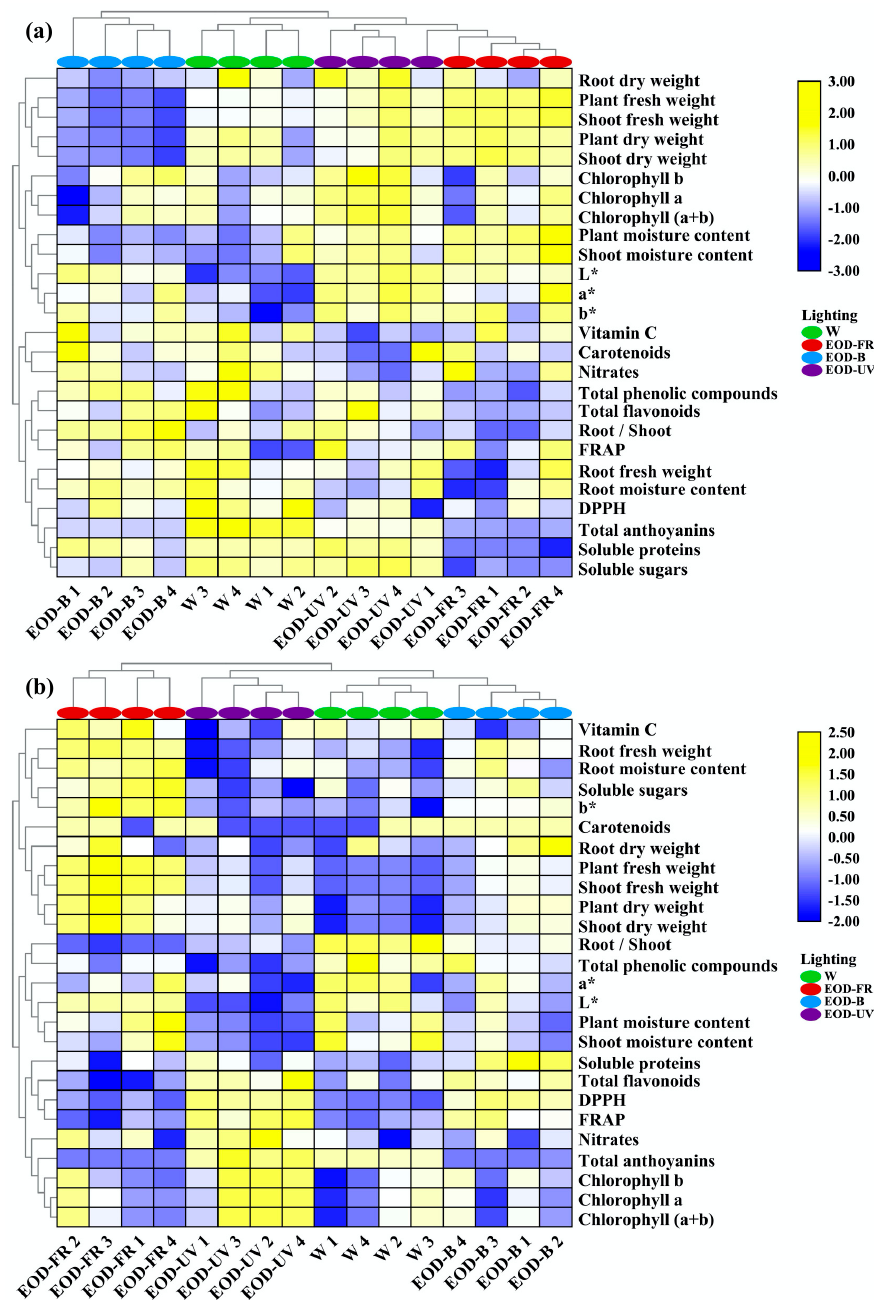
Figure 9. Cluster heatmap analysis summarizing lettuce responses to end-of-day lightings. ( a ) Heatmap of ‘Red butter’ and ( b ) ‘Green butter’ responses. Results are visualized using a false color scale with yellow indicating an increased parameter, and blue indicating a decreased parameter. W = day-white light, EOD-B = end-of-day enhanced blue light, EOD-FR = end-of-day far-red light, EOD-UV = end-of-day ultraviolet-A light.